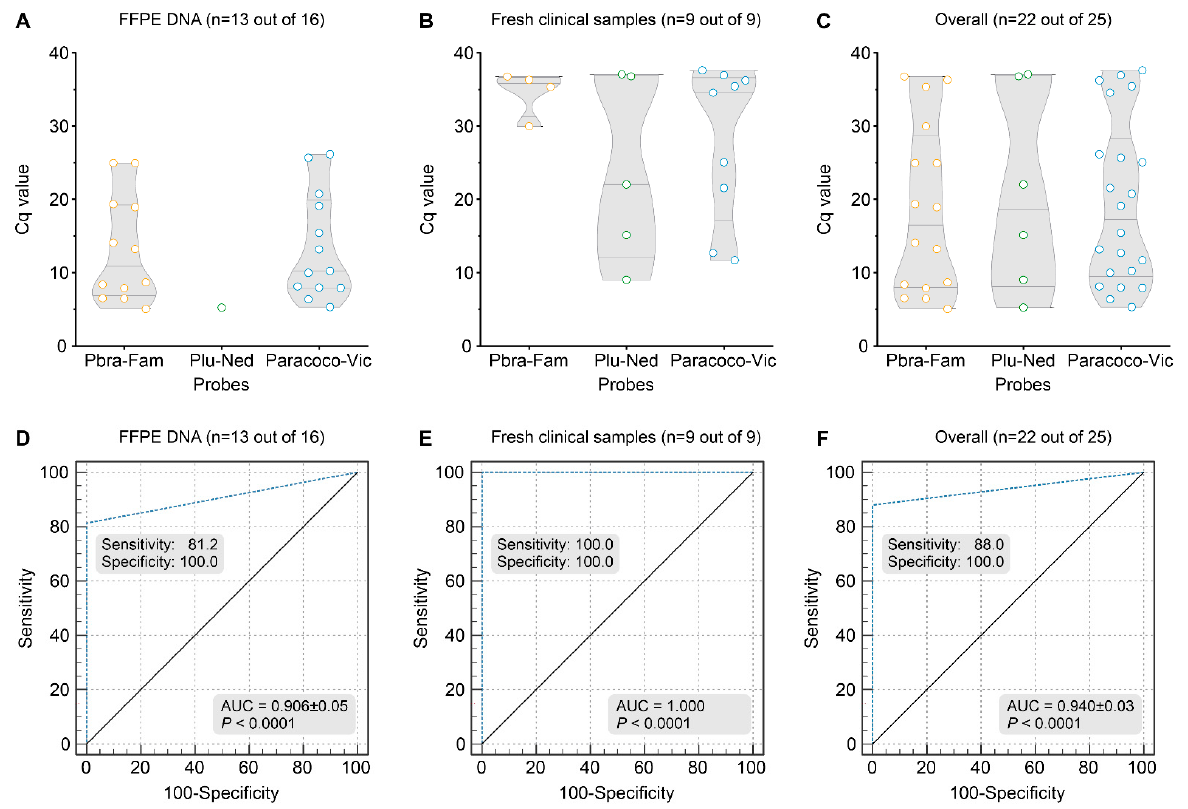
Figure 6. Summary of FFPE tissues (n = 16) or miscellaneous fresh clinical samples (n = 9), including sputum, pus, tissue biopsy, bronchoalveolar lavage, and cerebrospinal fluid, employed in our triplex-probe qPCR. ( A ) Scatter plot of Cq values (y-axis) from a group of 16 DNAs revealed that 13 specimens were positive for the Paracoco-Vic probe (81.2%; Mean Cq = 10.25), with 12 P. brasiliensis complex (PbraCx-Fam) and a single P. lutzii detected (Plu-Ned probe). ( B ) Scatter plot of Cq values (y-axis) from a group of nine DNAs revealed that nine specimens were positive for the Paracoco-Vic probe (100%; Mean Cq = 27.98), with four P. brasiliensis complex (PbraCx-Fam) and five P. lutzii detected (Plu-Ned probe). ( C ) Scatter plot of Cq values (y-axis) from overall samples (FFPE and fresh clinical samples). ( D ) ROC analysis for the triplex-probe qPCR reached 100% specificity, and 81.2% sensitivity as 13 FFPE samples were positive and only 3 samples were false-negative (AUC = 0.906 ± 0.05; p < 0.0001, 95% CI = 68.319–94.313, Youden index J = 0.8125, NPV = 85.67%, PPV = 100%). The 18 non-PCM samples remained negative. ( E ) ROC analysis for the triplex-probe qPCR reached 100% specificity and sensitivity as 9 fresh clinical samples were positive, and the 18 non-PCM samples remained negative (AUC = 1.000; p < 0.0001, 95% CI = 0.872–1.000, Youden index J = 1.000, NPV = 100%, PPV = 100%). ( F ) ROC analysis for the triplex-probe qPCR reached 100% specificity, and 88% sensitivity as 22 specimens were positive (13 FFPE samples and 9 fresh clinical samples) and only 3 samples were false-negative (AUC = 0.940 ± 0.03; p < 0.0001, 95% CI = 0.823–0.989, Youden index J = 0.8800, NPV = 85.7%, PPV = 100%). The 18 non-PCM samples remained negative. The results are typical of two separate